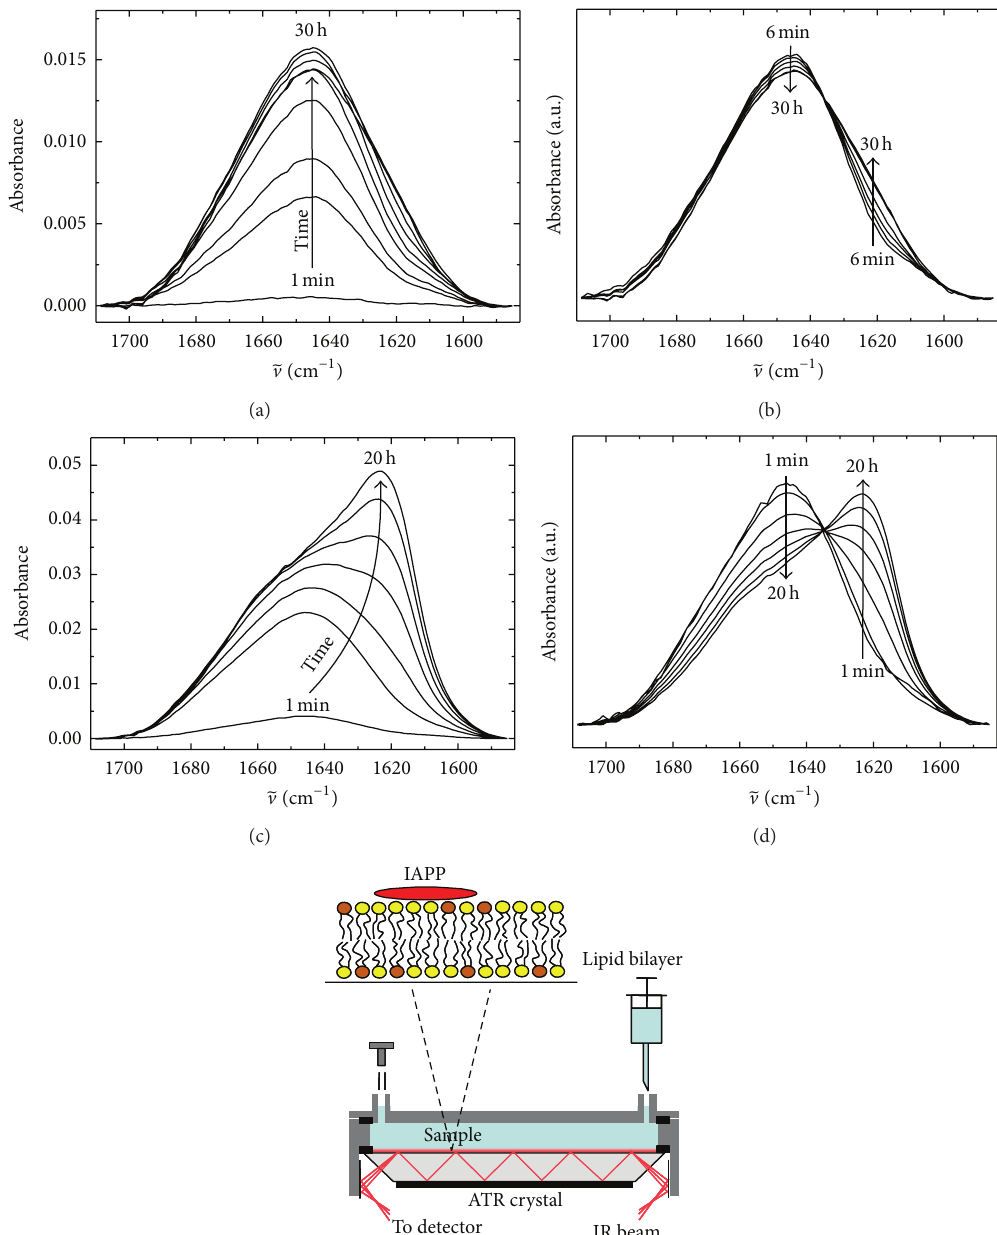
Figure 4: Time evolution of the secondary structural change of hIAPP aggregation by studying the amide-I 󸀠 bands at 25 ∘ C after injection into the ATR-FTIR cell. (a, b) 10 𝜇 M hIAPP in the presence of a neutral (zwitterionic) DOPC bilayer. (c, d) 10 𝜇 M hIAPP in the presence of a phospholipid bilayer consisting of DOPC/DOPG (7: 3, w/w). In (a) and (c), primary ATR-FTIR spectra are shown. In (b) and (d), intensity normalized spectra are depicted. A structural transition from partially 𝛼 -helical and disordered conformations to the formation of intermolecular 𝛽 -sheet occurs only in the presence of anionic lipid bilayers. (e) Schematics of the ATR-FTIR sample cell. hIAPP molecules adsorbing to and aggregating/fibrillating at the lipid bilayer membrane are detected, while those distant from the membrane are merely visible owing to the low penetration depth of the evanescent wave in the ATR-FTIR setup. Adapted and modified from [56] with permission from